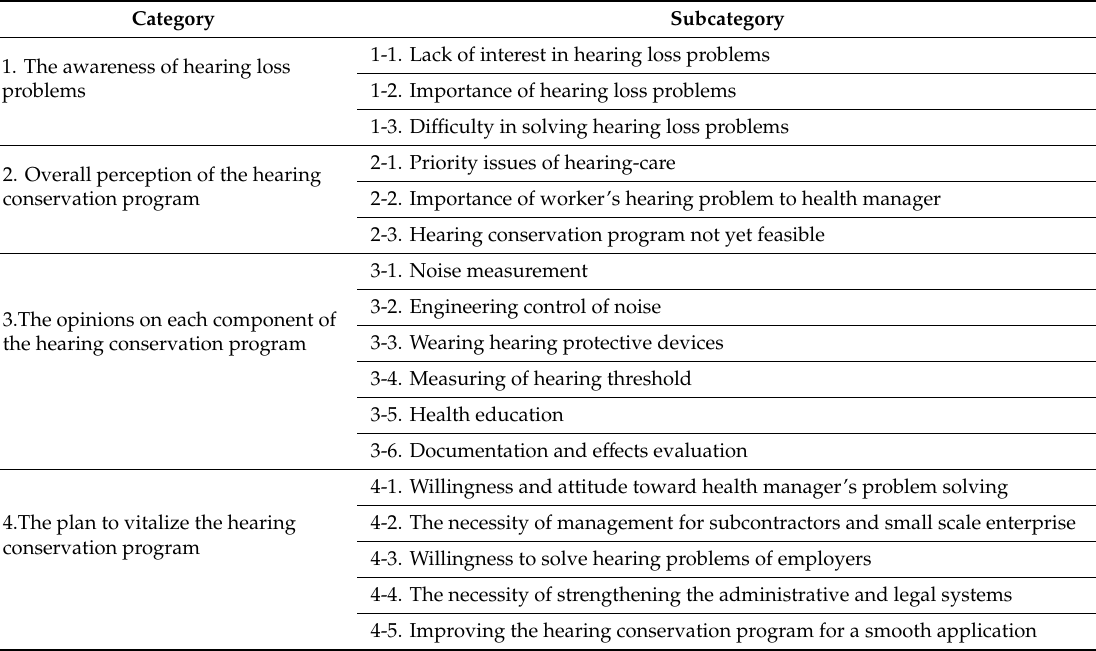
Table 2. Structure of the analysis results and the main